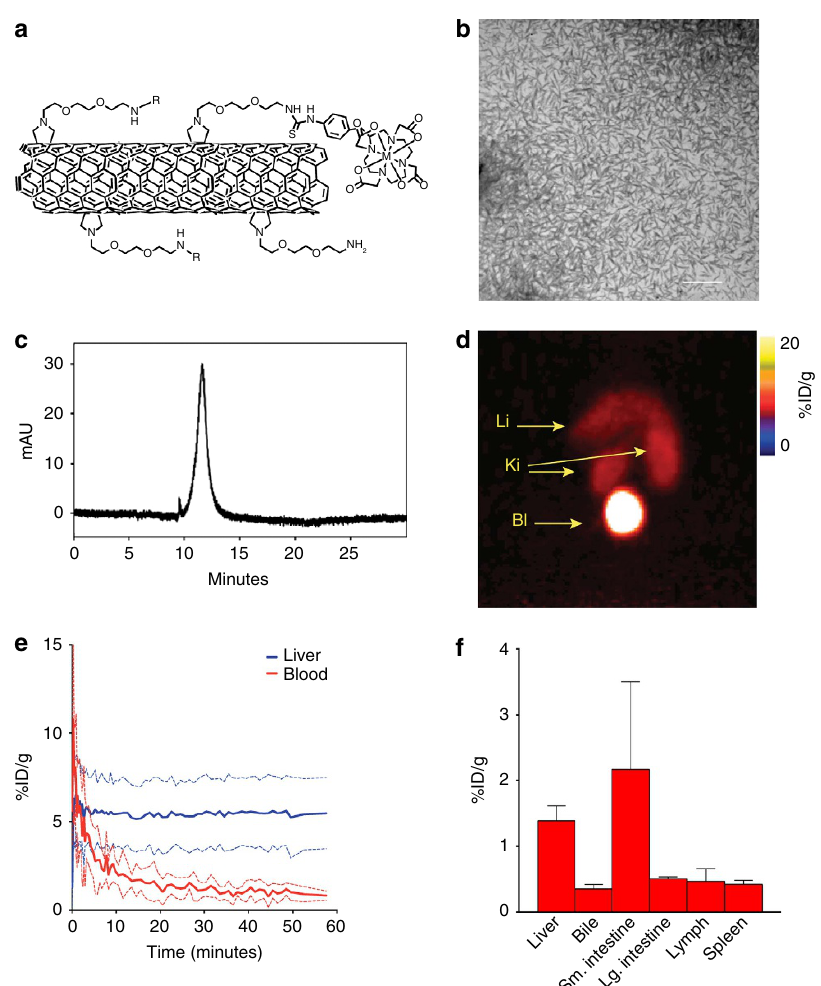
Figure 1 | Nanomaterial characterization and murine pharmacokinetics. ( a ) Graphic illustration of the ammonium-functionalized single walled carbon nanotube (fCNT) appended with a DOTA radio-metal ion chelate. NB, Figures are not drawn to scale. ( b ) TEM image of purified fCNT (scale bar,